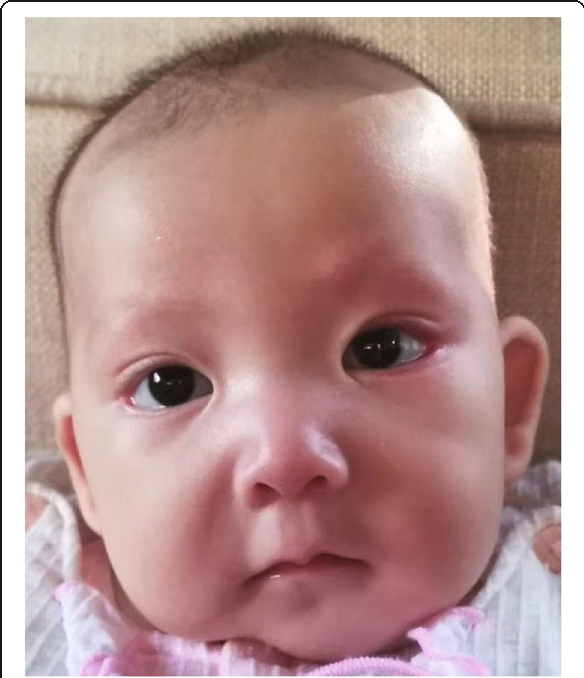
Fig. 2 The facial features of the patient at three months